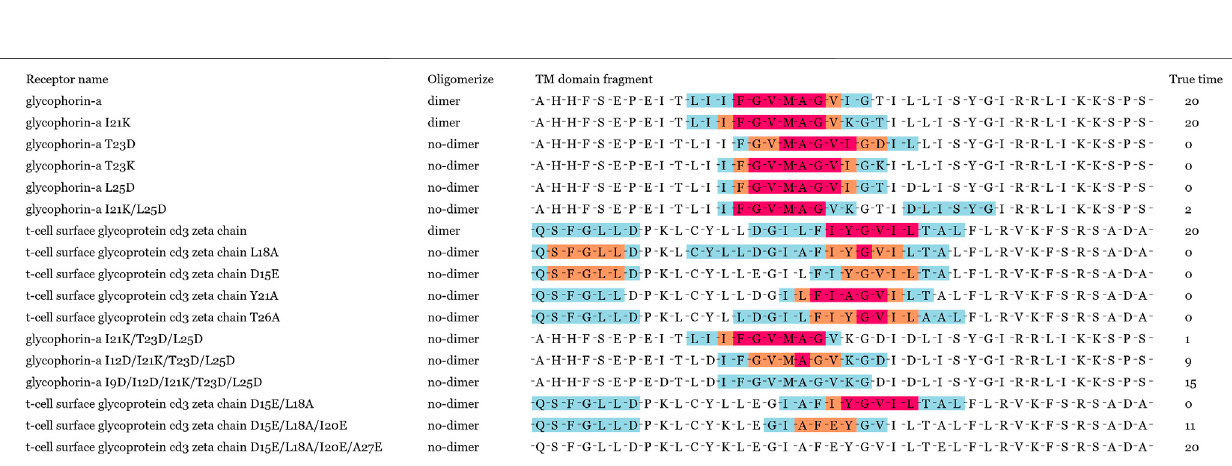
Frontiers in Genetics |